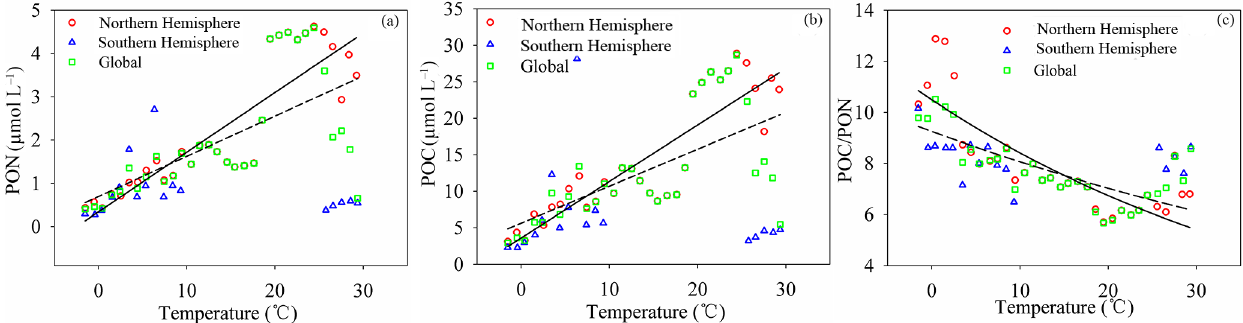
Figure 10. Relationships between POC, PON, and POC / PON and temperature (T ) . POC, PON and POC / PON are highly correlated with temperature in the Northern Hemisphere (solid line), with relationships of PON = 0 . 142 · T + 0 . 260 (R 2 = 0 . 74 ) , POC = 0 . 788 · T + 3 . 340 (R 2 = 0 . 74) and POC / PON = 11 . 88 · T − 0 . 190 (R 2 = 0 . 81), respectively. There is almost no correlation in the Southern Hemisphere, with correlation coefficients of − 0 . 11, − 0 . 08 and − 0 . 31 for PON, POC and POC / PON, respectively. The relationships between POC, PON, and POC / PON and T at a global scale (dashed line) are PON = 0 . 093 · T + 0 . 697 (R 2 = 0 . 42 ) , POC = 0 . 507 · T + 5 . 630 (R 2 = 0 . 41 ) and POC / PON = 10 . 02 · T − 0 . 122 (R 2 = 0 . 57 )